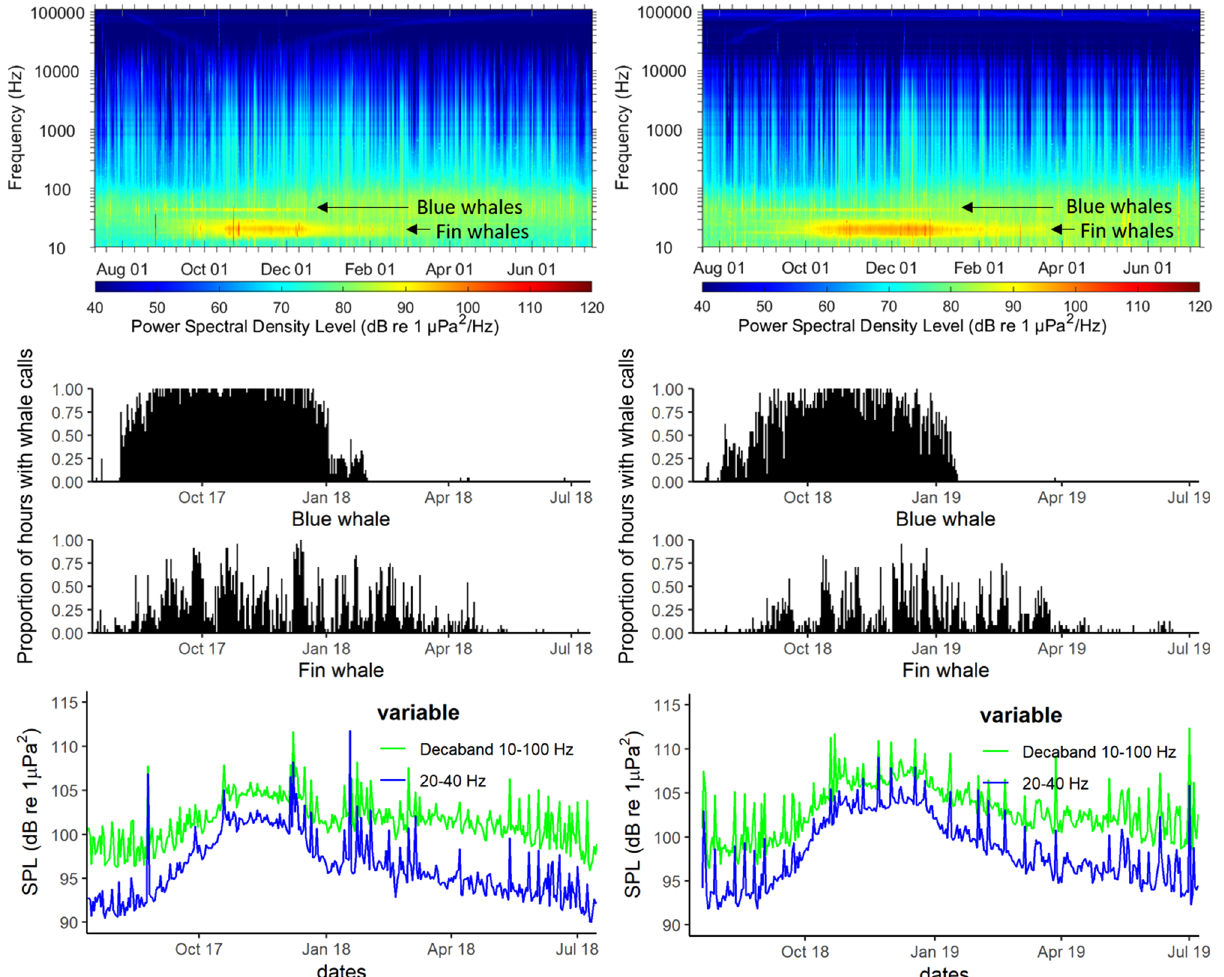
Figure 13. Passive acoustic monitoring data from the Gowgaia Slope hydrophone in 2017–2018 (left) and 2018–2019 (right). Long-term spectrograms showing blue and fin whale call presence (top). Proportion of hours each day with blue or fin whale calls (middle). Sound pressure levels (SPLs) for decaband 10–100 Hz (green) and decaband 20–40 Hz (blue)